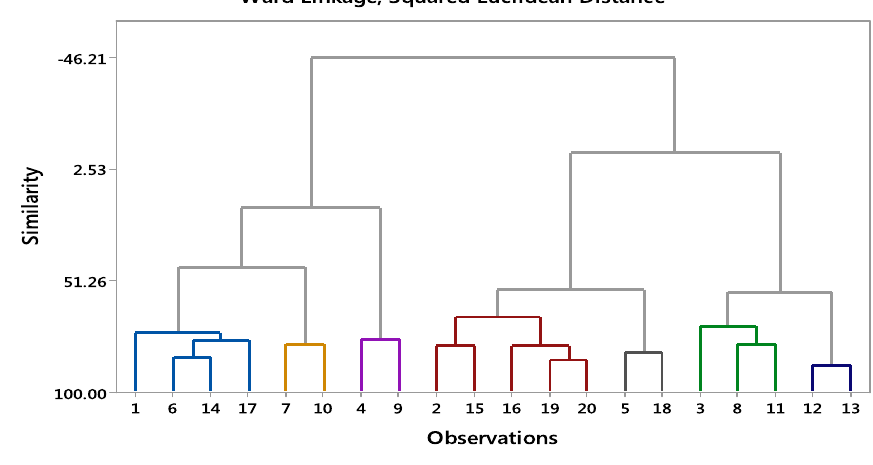
Fig. 3 Dendrogram of spatial similarities between monitoring stations formulated by